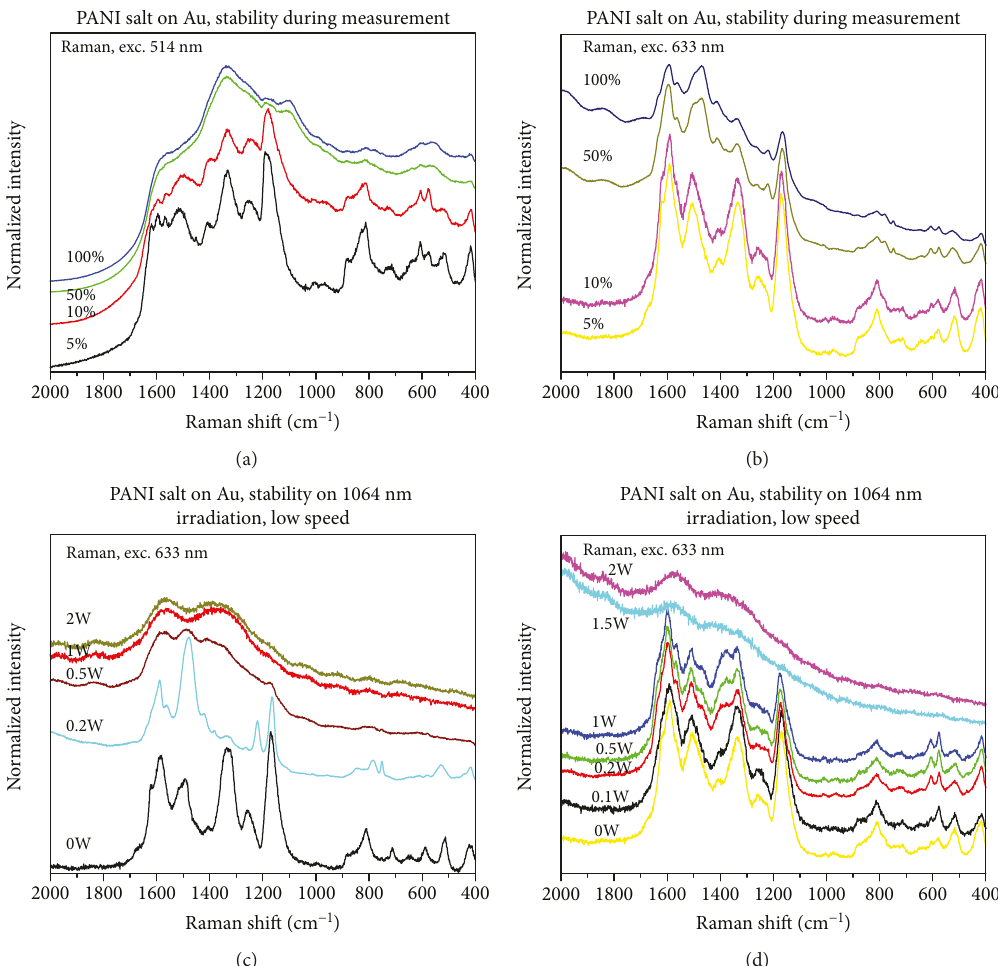
Figure 2: Raman spectra of a PANI fi lm on gold support burned with various powers of 514, 633, and 1064nm radiation (for burning with the 1064 nm line, the spectra were measured subsequently with the low-power 633nm line).